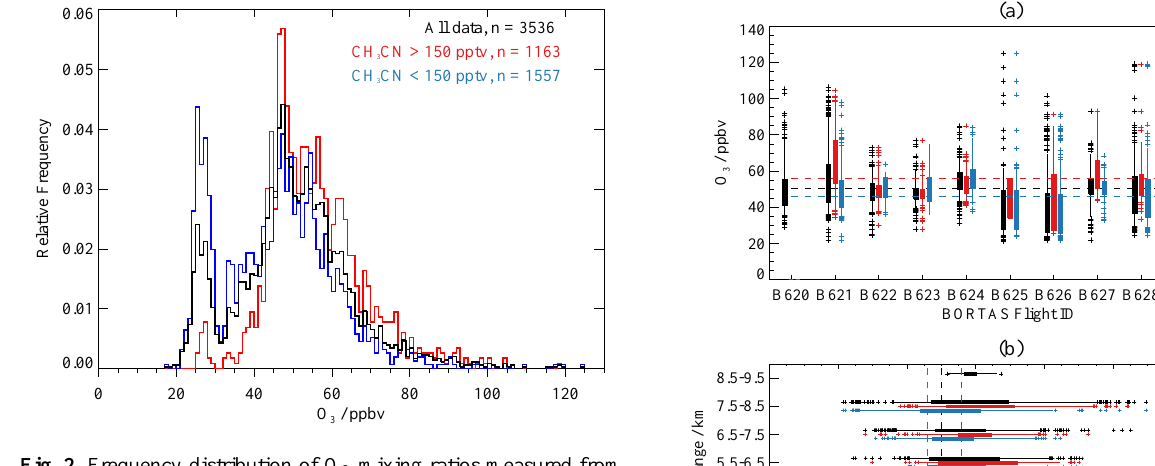
Fig. 2. Frequency distribution of O 3 mixing ratios measured from the BAe-146 on all research flights during the BORTAS campaign period (15 to 31 July 2011). Frequencies are calculated for 1ppbv bins. The black line shows the distribution of all the measured O 3 mixing ratios, the red line shows the distribution of measurements identified as biomass burning plumes using a threshold of CH 3 CN mixing ratios greater than 150pptv, and the blue line shows mea- surements made in air masses with CH 3 CN mixing ratios less than 150pptv. The number of data points, n , for each distribution are shown in the legend. Fig.3. BoxandwhiskerplotsshowingthestatisticaldistributionofO 3 measurementsmadefromtheBAe-146during